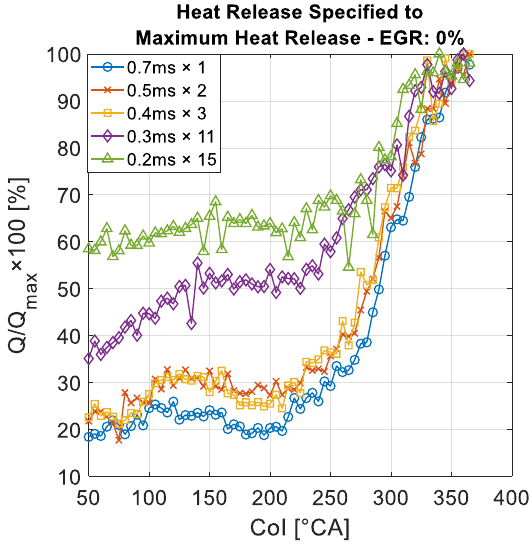
Figure 5. The heat release specified to maximum heat release. MBI has less heat release reduction at early CoIs.